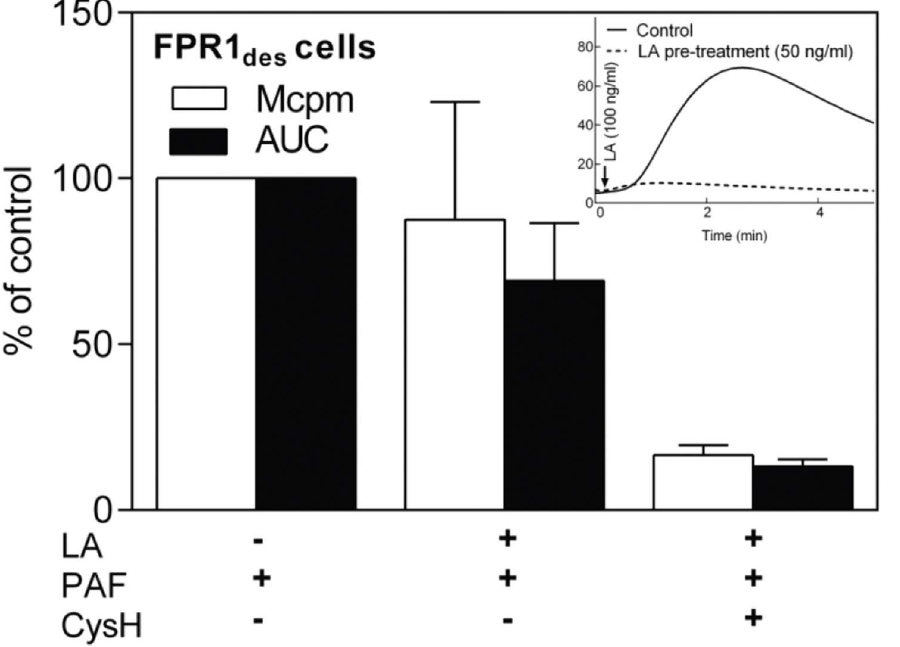
Figure 8. PAF activates FPR1 des neutrophils also in the presence of latrunculinA. Human FPR1 des neutrophils were incubated in the absence or presence of latunculinA (LA, 50 ng/ml) and after return of the NADPH-oxidase activity to background levels (after around 20 min; not shown in the figure) the cells were activated with PAF (100 nM) and the measurement of oxidase activity was started. In some experiments, cyclosporinH (CA, 1 m M) was added to the cells just prior to PAF. The response induced was sensitive to this FPR1 specific antagonist. The results are expressed as peak response (Mcpm, open bars) and total production (area under curve; AUC, filled bars) in percent of control (PAF-induced peak response in FPRdes in the absence of LA and CA; mean 6 SEM, n=3). The FPR1 des neutrophils treated with latrunculin A (50 ng/ml) could not be reactivated by additional latrunculin A (100 ng/ml, inset, dotted line). For comparison, reactivation of control cells (FPR1 des neutrophils without latrunculin A pre-treatment, solid line) is